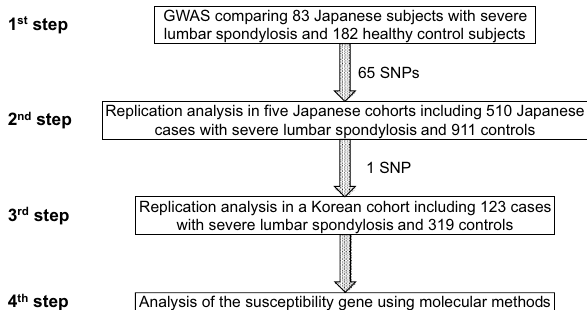
Figure 1. Summary flowchart of the present